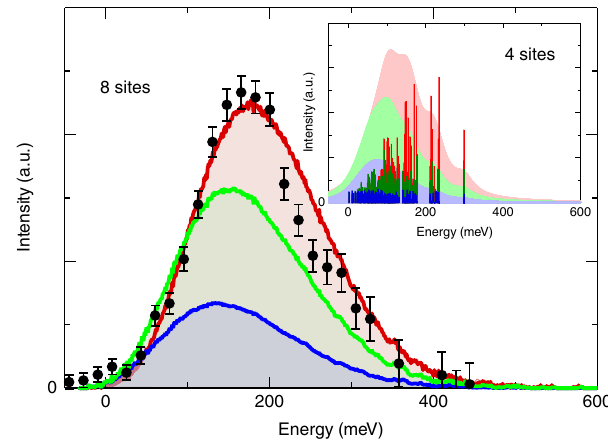
Figure 4 | Spin-orbit-driven magnetic excitation from an AIAO ground state in Cd 2 Os 2 O 7 . Eight site ED calculations, including resolution broadening, showing the character and amount of excited eigenstates at a particular energy. The scaled-experimental data (black) is shown after background subtraction with error bars representing 1 s.d. The ED results green and red, respectively. The strong SOC and consequently DM interactions in the magnetic ground state and excited states of Cd 2 Os 2 O 7 result in a superposition of these D S z spin-states all contributing to the excitation. The calculated intensity corresponds to the DOS and therefore the actual experimental intensity distribution of the excitation measured by the RIXS cross section is likely dominated by the D S z ¼ 1 process, followed by D S z ¼ 2 and then D S z ¼ 3. Inset corresponds to 4-site calculations and highlights the mixing and energy distribution of the D S z